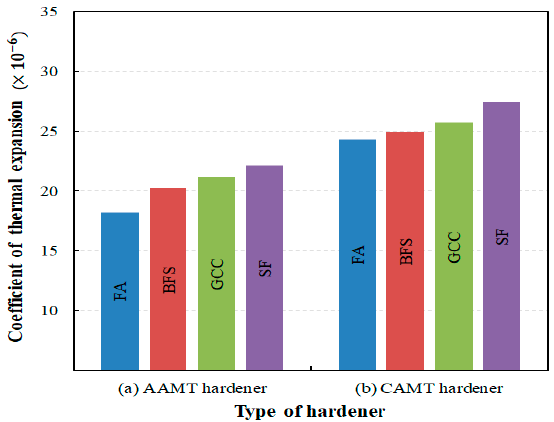
Figure 11. Coefficients of thermal expansion by hardener and filler type.